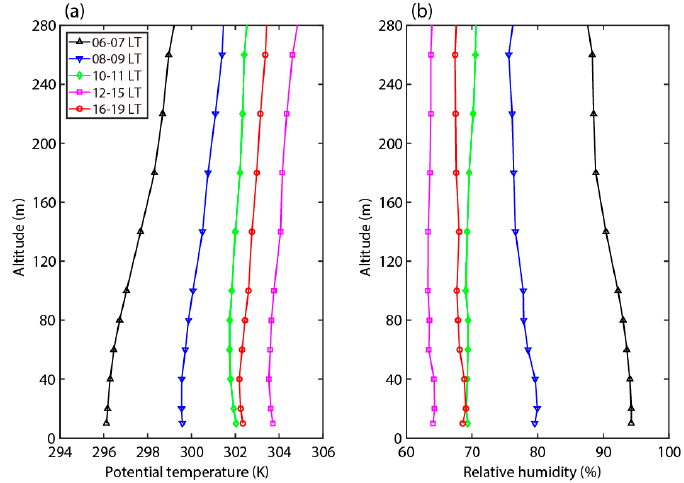
Figure 5. Vertical profiles of ( a ) potential temperature and ( b ) relative humidity observed using the UAV at 06–07 (black triangle), 08–09 (blue inverse triangle), 10–11 (green diamond), 12–15 (purple square), and 16–19 LT (red circle). Atmosphere 2020 , 11 , x FOR PEER REVIEW